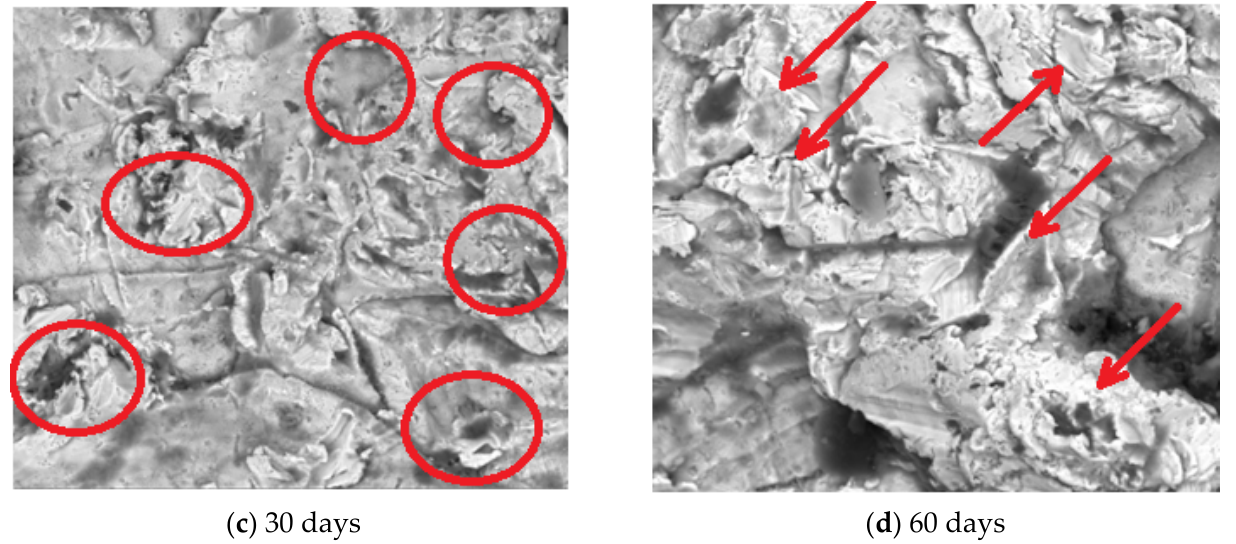
Figure 1. SEM images showing surface corrosion of 3D-printed CoCrMo metallic implant during SBF exposure. ( a ) Initial (0 h); ( b ) after 15 days; ( c ) after 30 days; ( d ) after 60 days.